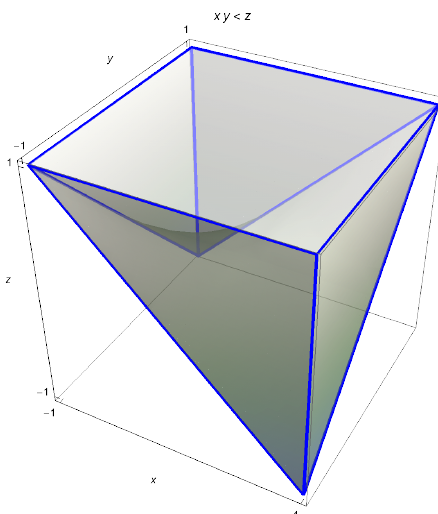
Figure 1. Convergence region xy < z for functions Φ F and Φ K